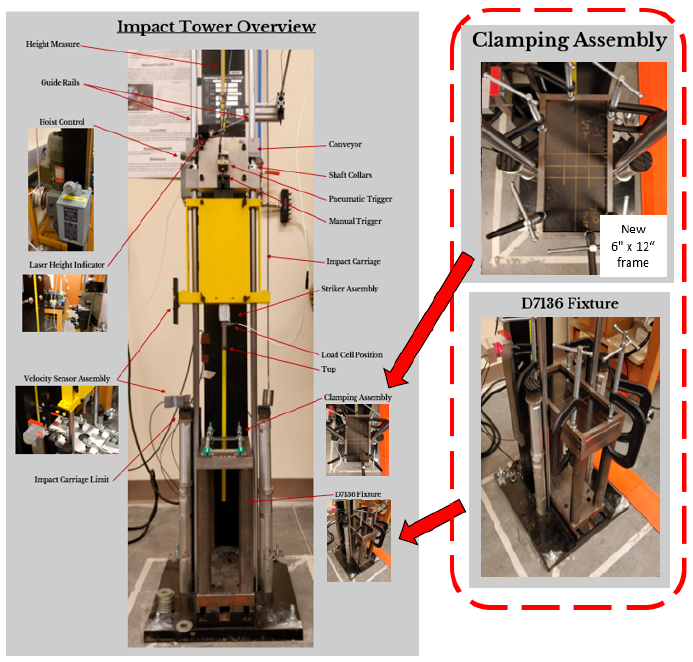
Figure 5. Dynatup 8200 drop-weight impact testing machine with modified